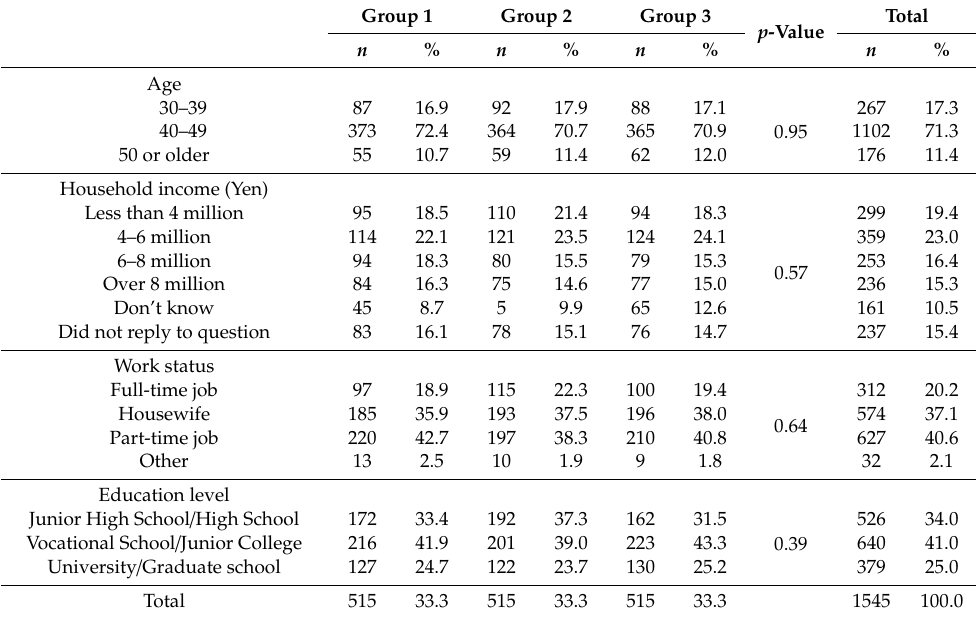
Table 1. Characteristics of the internet survey